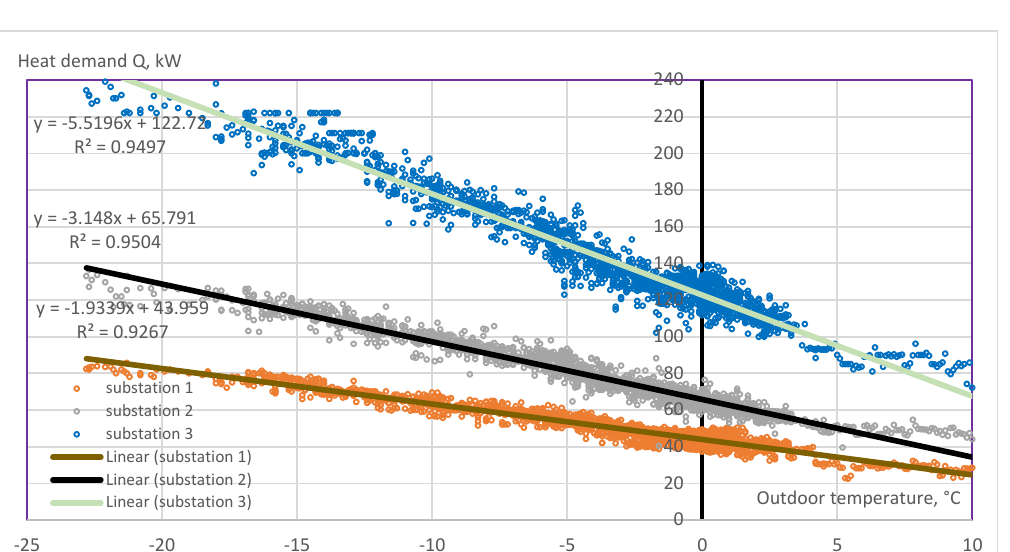
Figure 2. Dependence of the heat demand on the outdoor air temperature.